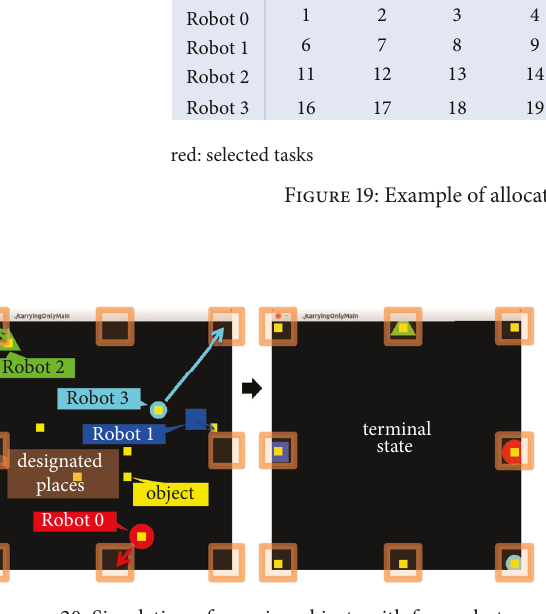
Figure 20: Simulation of carrying objects with four robots.